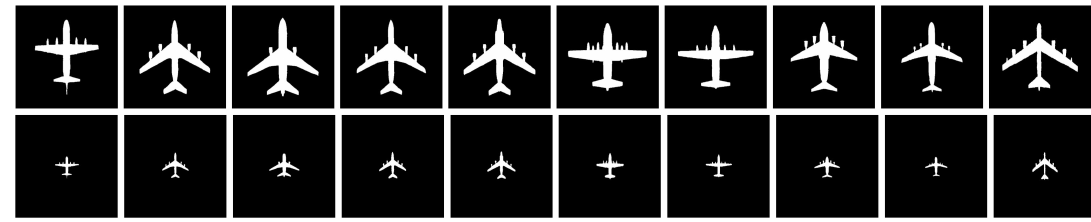
Figure 7. Examples of shape alignment. The first and second row represent the original templates and the results of shape alignment, respectively.